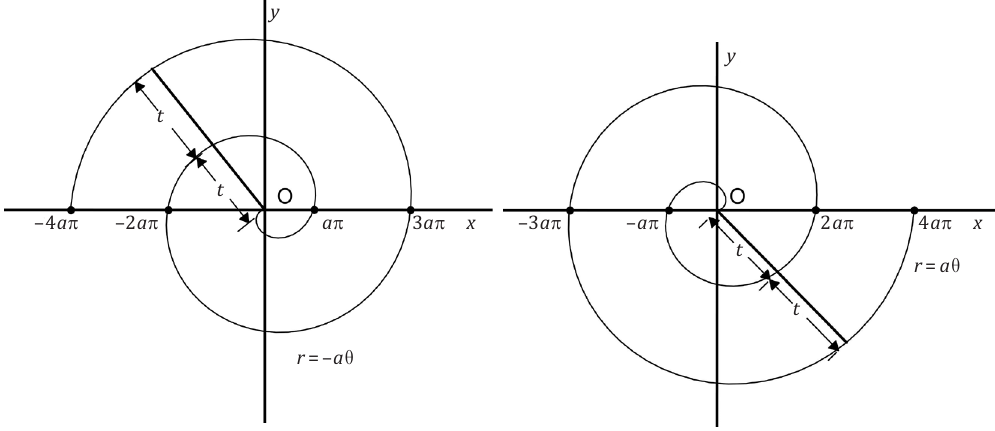
Figure 4. The Archimedean spiral r = a q for Figure 5. The symmetric spiral r = – a q